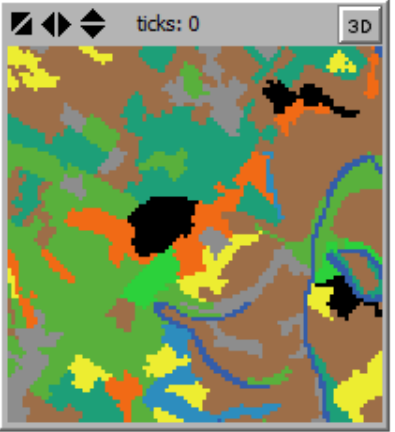
Figure 15. The landscape heterogeneity - recorder world with the highest potential.